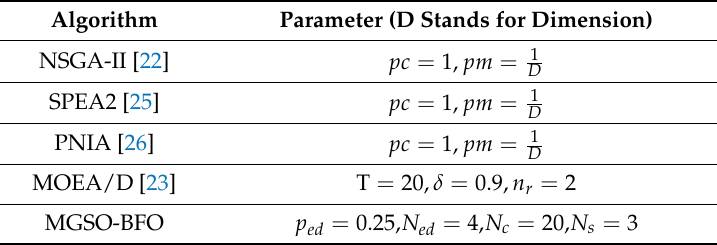
Table 2. Parameter settings of 4 different